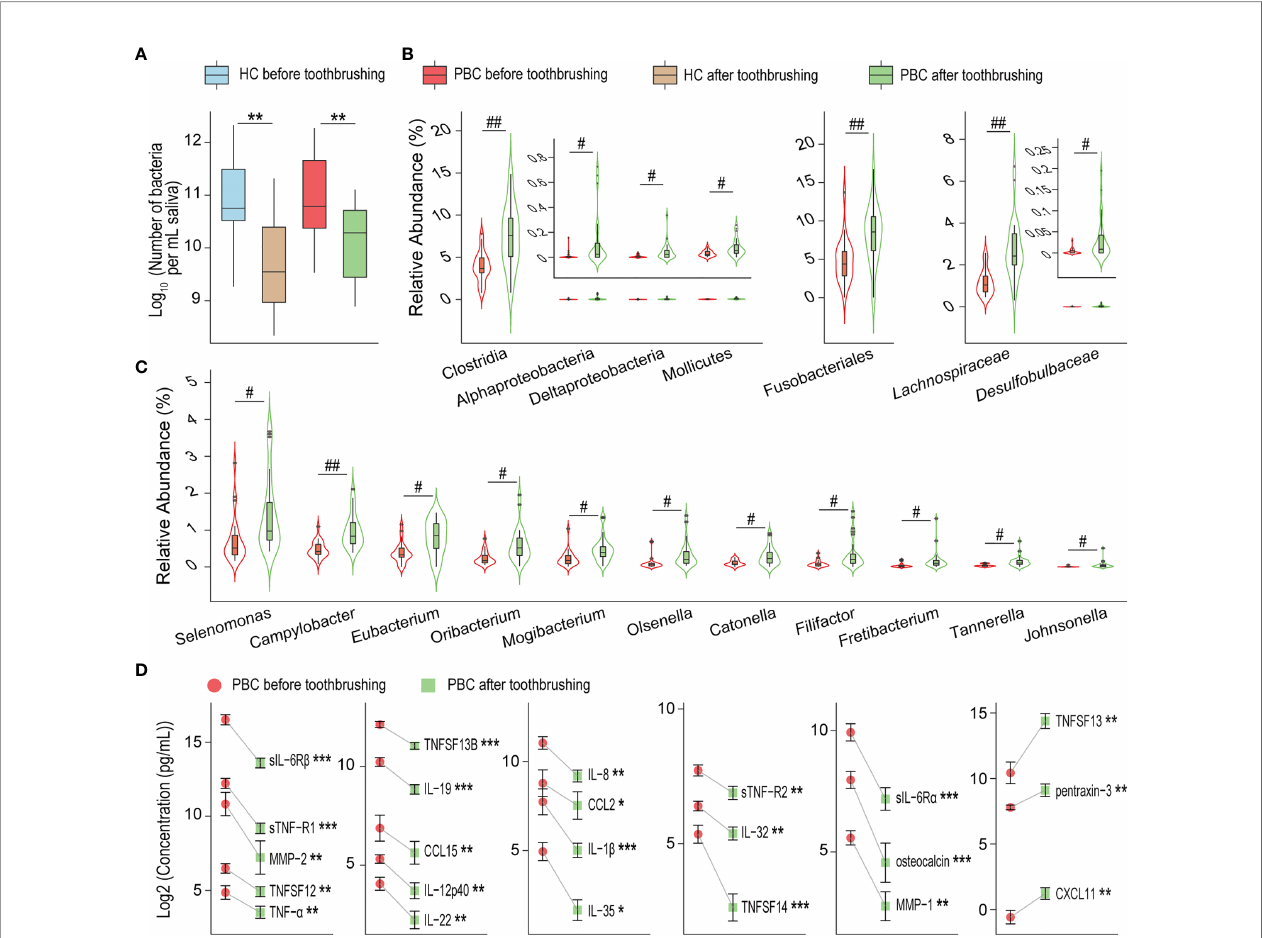
FIGURE 5 | Toothbrushing reduces the number of in fl ammatory cytokines in PBC saliva more than that in HC saliva. (A) Number of bacteria per millilitre of saliva in PBC patients and healthy controls before and after toothbrushing. (B) and (C) Bacterial taxa with higher relative abundances in PBC saliva after toothbrushing than before toothbrushing. (D) In fl ammatory cytokines that were signi fi cantly reduced from before to after toothbrushing in PBC saliva. * P < 0.05; ** P < 0.01; *** P < 0.001; # P ## P adj < 0.05; adj <